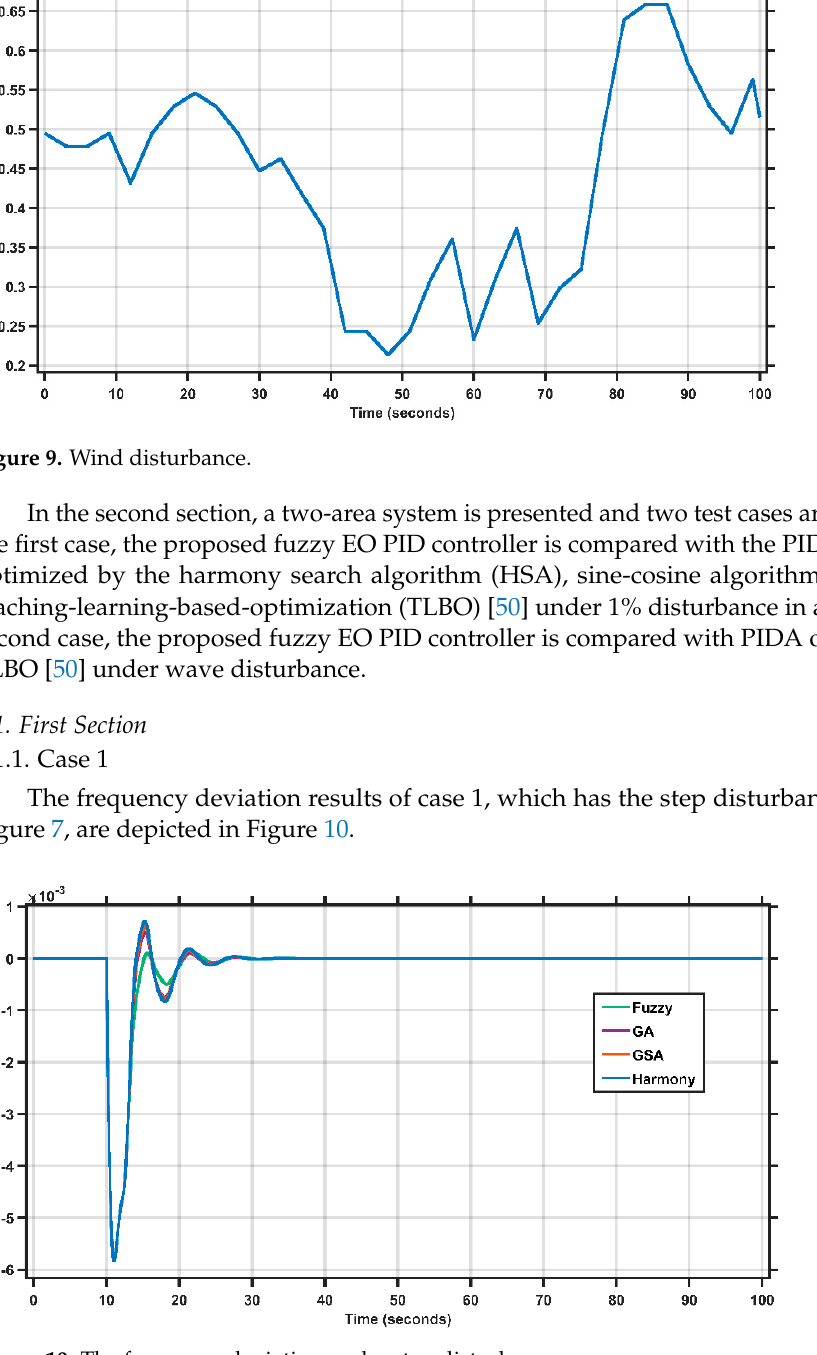
Figure 10. The frequency deviation under step disturbance.